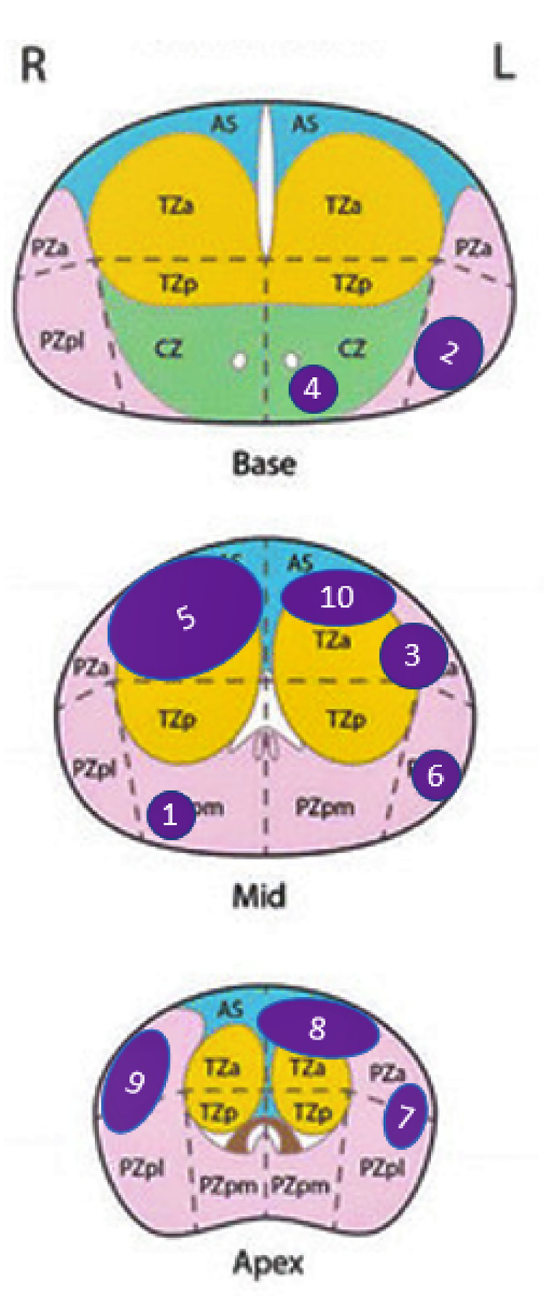
Fig 2. Index tumor location at baseline in the 10 patients before targeted FMA. Schematic view of index tumor location. Index tumors have been represented with a 1:1 scale on a prostate with 4 cm height (antero-posterior axis), 6 cm width (lateral